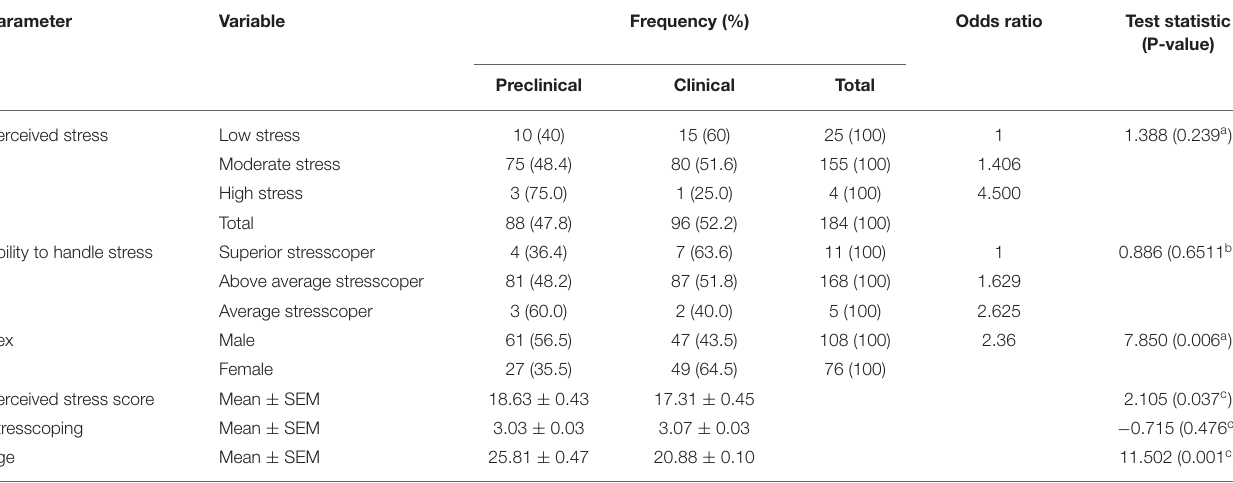
TABLE 3 | Stress, ability to handle stress, and gender among preclinical and clinical students in Uganda. Parameter Variable Frequency (%) Odds ratio Test statistic